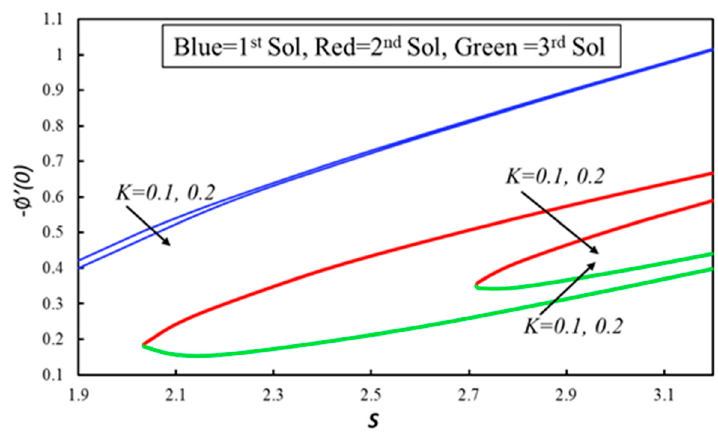
Figure 18. Concentration transfer rate with various values of S.